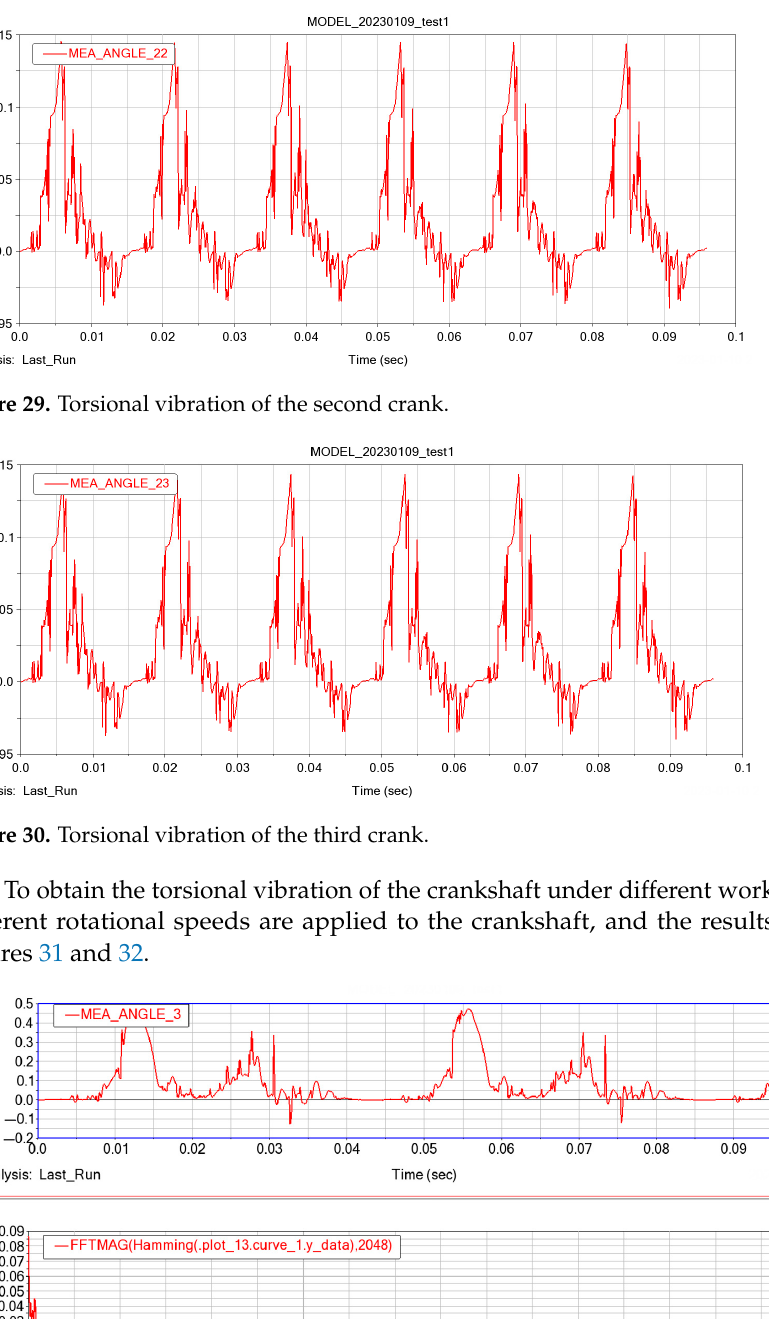
Figure 28. Torsional vibration of the fi rst crank.